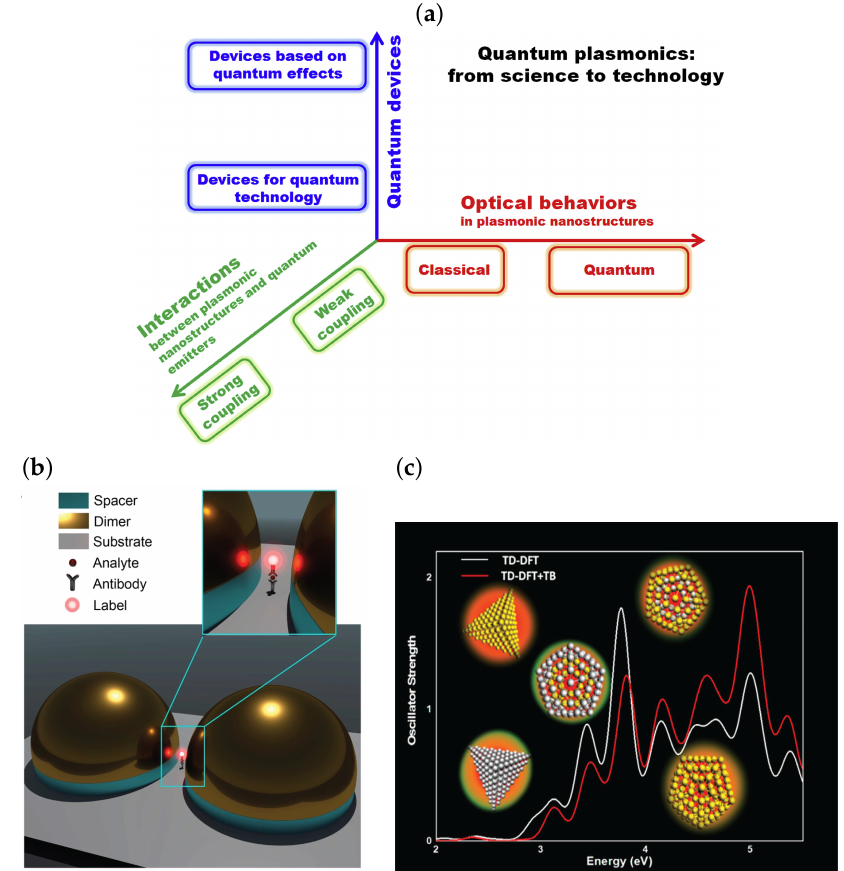
Figure 2. ( a ) Science and technology towards quantum plasmonic devices. ( b ) Plasmon-enhanced quantum immunoassay sensing. A schematic diagram of the strong-coupling immunoassay con- figuration shows that an immunoassay complex is trapped in the vicinity of a plasmonic hotspot within a nanodimer cavity made of gold hemispheres. ( c ) The plasmonic response of bimetallic assemblies with various proportions of silver and gold atoms obtained with an advanced density functional theory technique to calculate excited states. ( a ) Reproduced with permission from